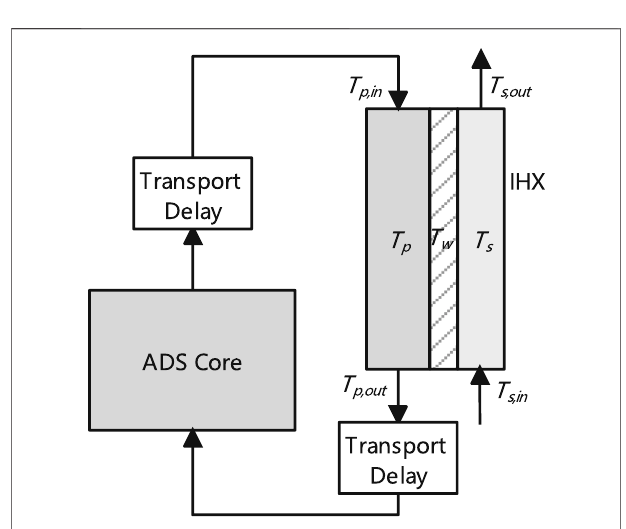
FIGURE 4 | Schematic diagram of primary